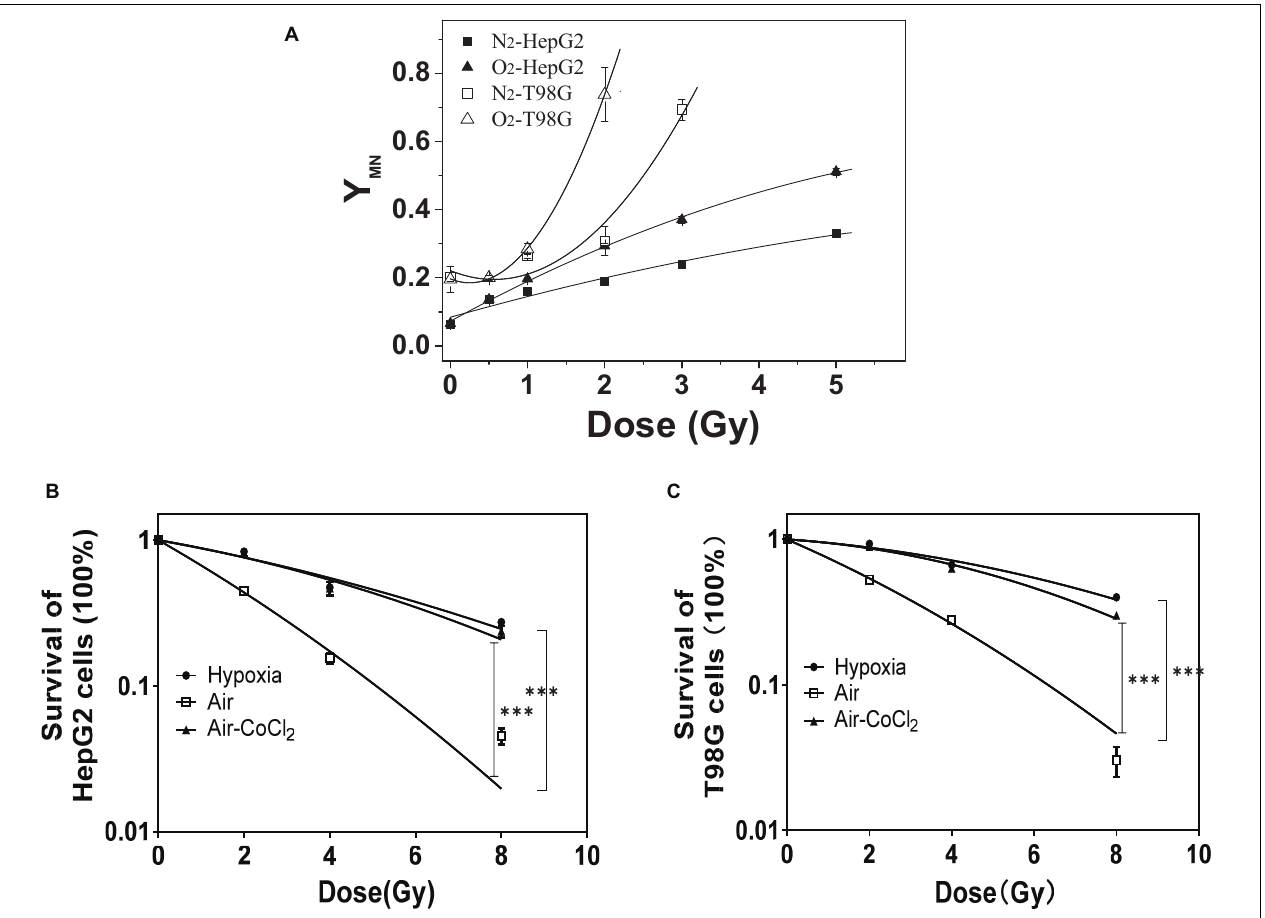
FIGURE 1 | The role of hypoxia on radioresistance in HepG2 and T98G cells. The micronucleus yields of irradiated HepG2 cells and T98G cells (with 0, 0.5, 1, 2, 3, or 5 Gy X-ray) were detected under normoxic or hypoxic conditions (A) . Cell survival was analyzed for HepG2 cells (B) and T98G cells (C) under normoxic, hypoxic, or 100 µ M cobalt chloride (CoCl 2 ) pretreatment. *** p < 0.01 between indicated